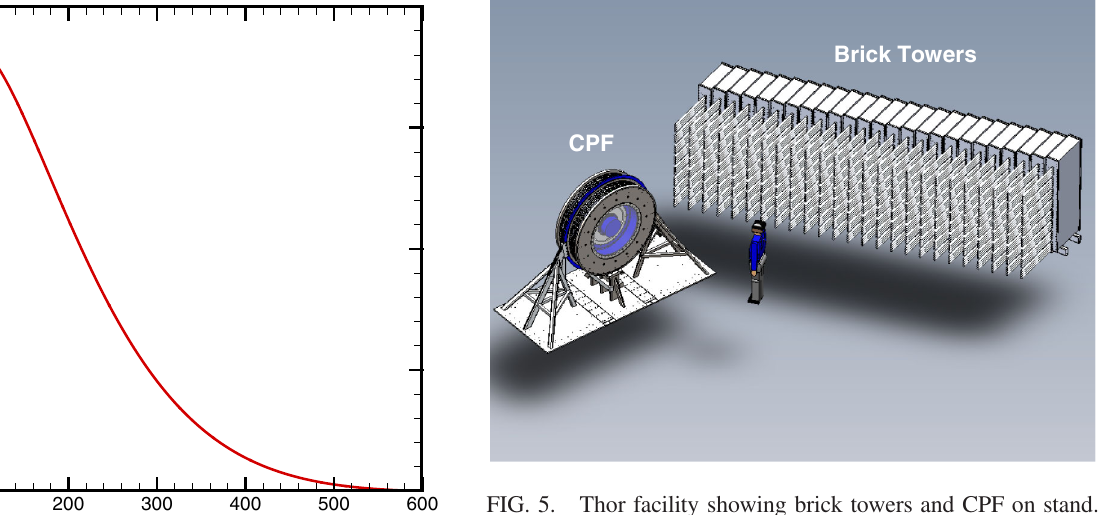
FIG. 5. Thor facility showing brick towers and CPF on stand. Cable runs are not